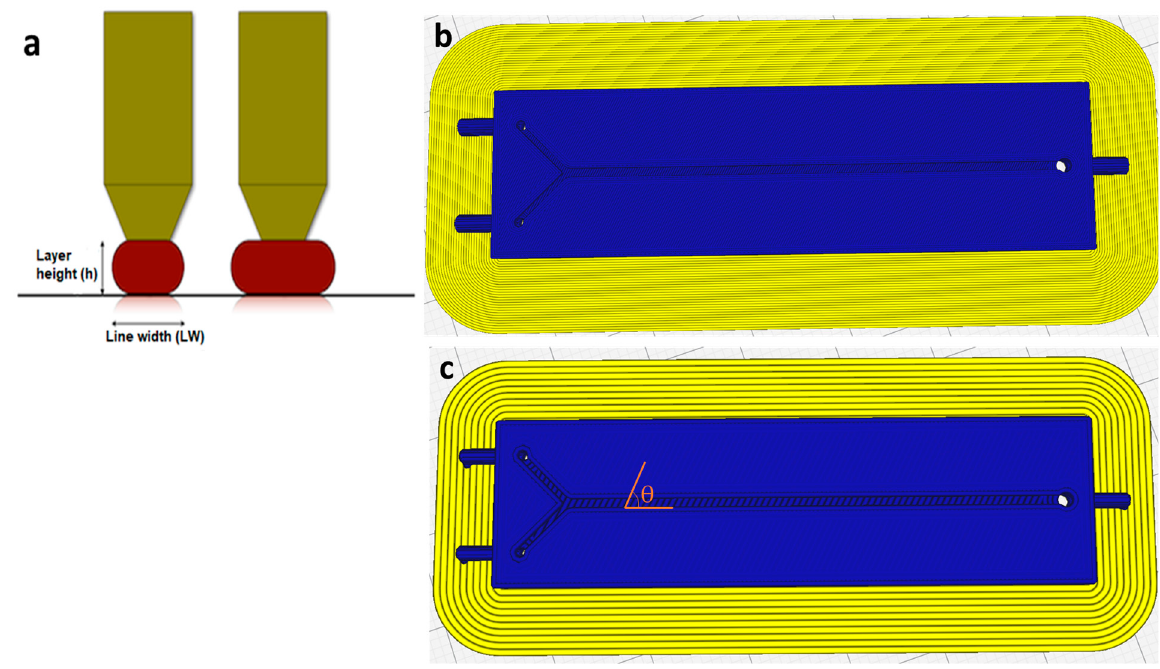
Figure 2. Printing parameters: ( a ) the geometry of the extruded filament; ( b , c ) show the movement path of the printing nozzles with two different infill line widths, 200 and 600 μ m, respectively. The angle θ denotes the orientation of the extruded filament relative to the fluid flow in the channel. Table 1. Fixed printing parameters during the experiments.